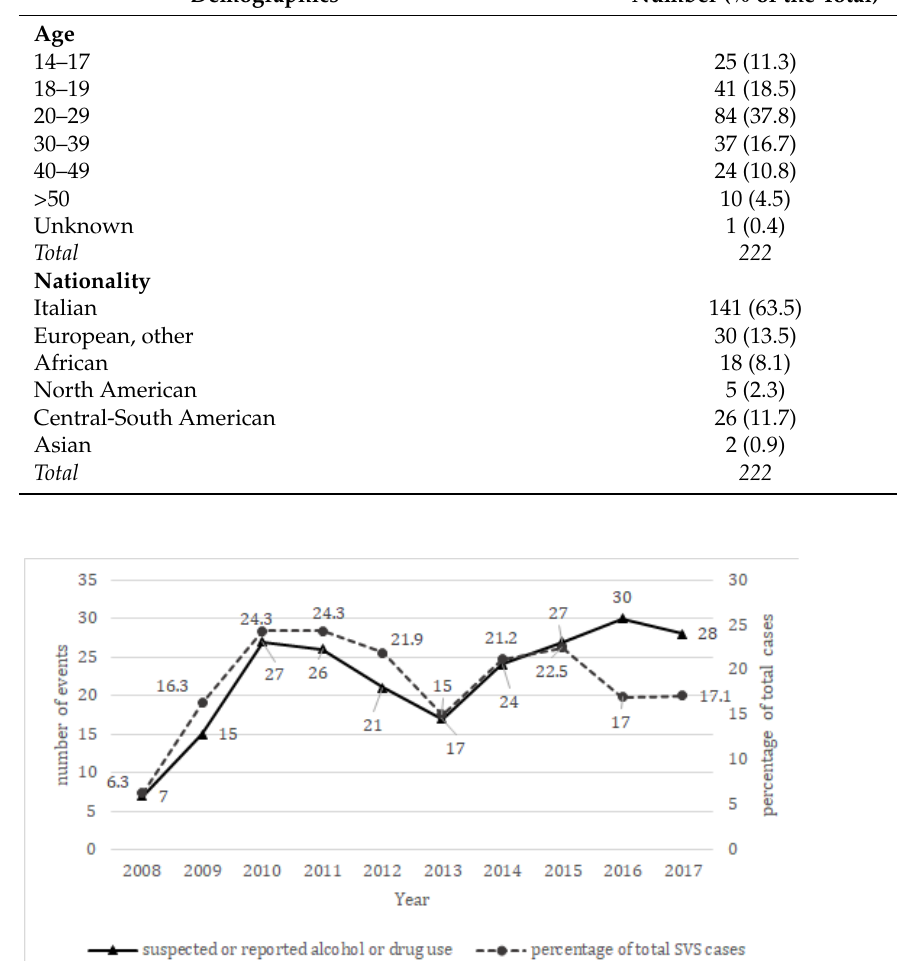
Figure 1. Suspected or reported alcohol or drug use : numbers of sexual violence events related to a suspect or reported alcohol and/or drugs intake detected by year (black line, right Y axis) and their relative percentage towards total number of cases accessing the SVS (dotted line, left Y axis).